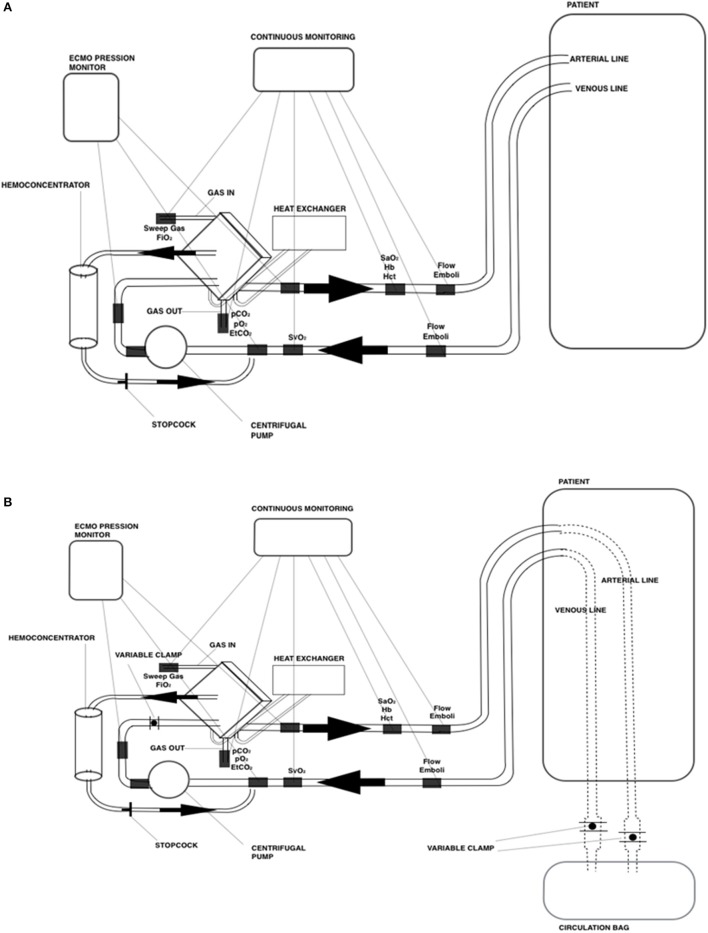
Schematic drawing of the ECMO circuit used for (A) animal laboratory and (B) mannequin-based simulations.